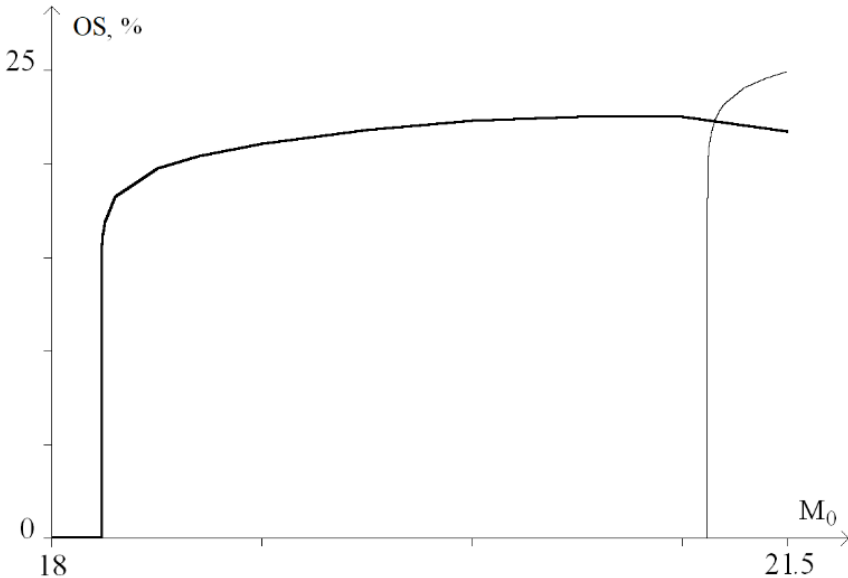
Figure 17. Graphs of the probability (in percent) of OS occurrence under the localized torque action on the segment [781, 830] (thin line) and the segment [831, 880] (thick line).